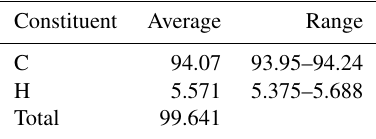
Table 1. Chemical composition of freitalite.